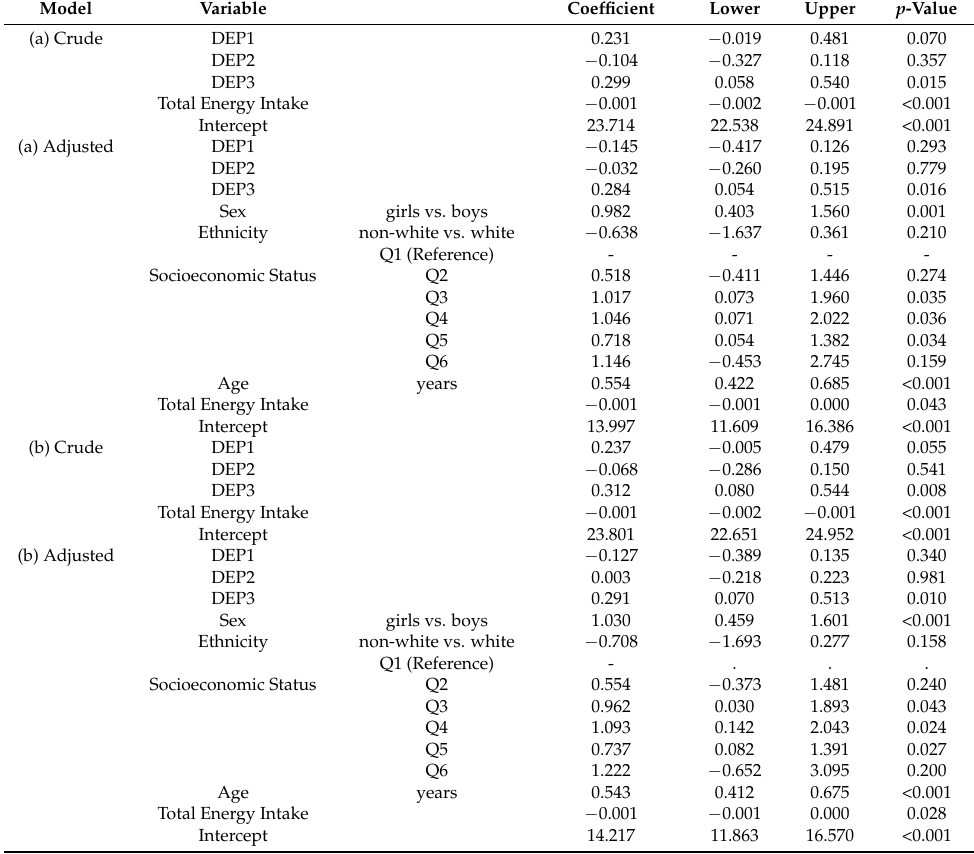
Table 3. The coefficient estimates from the crude and adjusted complete case (a) and imputed (b) multiple regression models relating diurnal eating patterns (exposures) and BMI (outcome), accounting for the complex survey